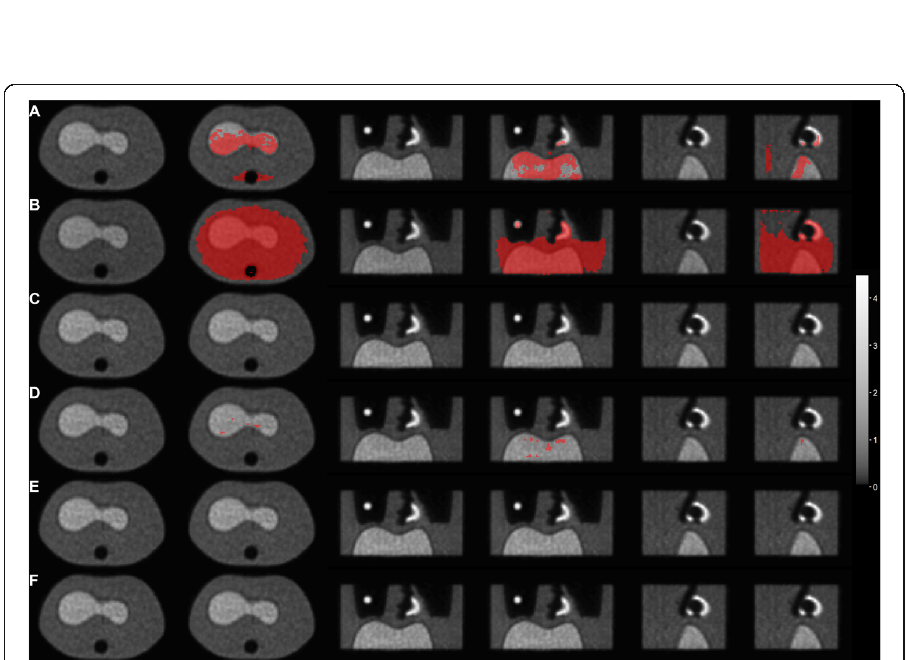
Fig. 6 Representative axial, coronal and sagittal images of the phantom for 3 representative CT acquisition parameter combinations for low (CTDI 0.3 mGy) ( a , b ), medium (CTDI 1.0 mGy) (C,D) and high (CTDI 3.3 mGy) ( e , f ) X-ray exposure. CT reconstructed with FBP ( a , c , e ) and iteratively ( b , d , f ). The grayscale images are from the TR reconstruction (scale SUV 0 – 4.5). The adjacent image shows those voxels in the TR that differ by greater than the QSD from the RR overlaid in